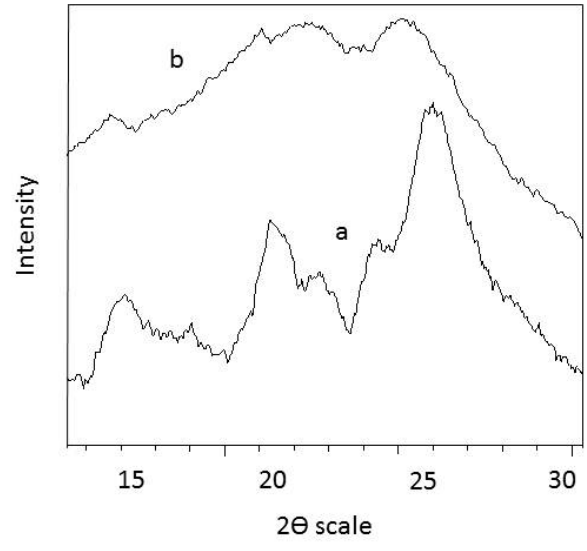
Figure 5. XRD analysis of ( a ) Polyaniline nanofibers obtained at aniline/oxidant = 4.0; and ( b ) irregular polyaniline micro-size particle obtained at aniline/oxidant =